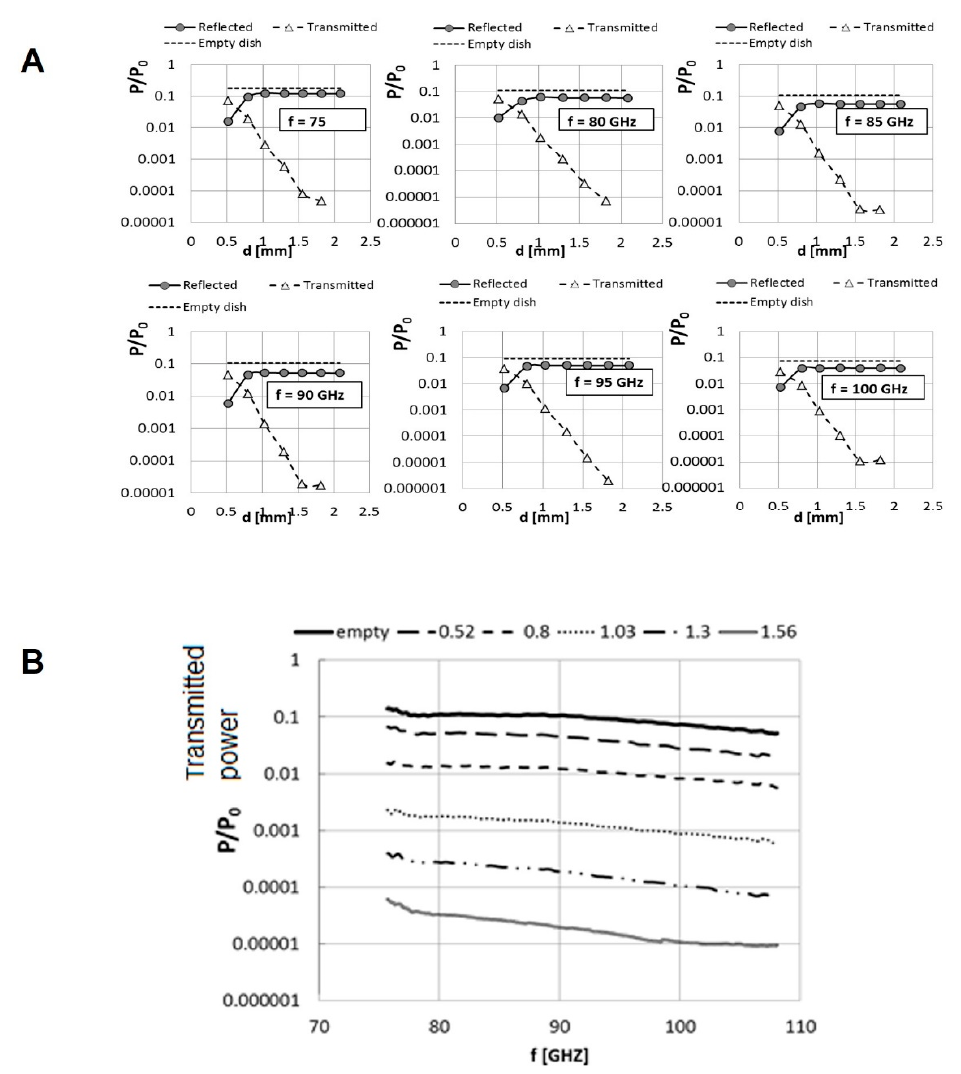
Figure 2. Dependence of the reflected and the transmitted signals on the level of the RPMI 1640 medium layer’s thickness ( A ). Signals were evaluated for di ff erent frequencies ranging from 75 to 100 GHz. For the empty dish, only the transmitted signal and not the reflected signal is presented. Shown is one representative sample of seven dishes that were irradiated for each frequency. Exposure times were a few seconds and the temperature of the medium was measured to be 24–26 ◦ C. Dependence of the transmitted power through the Petri dish on the frequency of irradiation ( B ). The signals were normalized to the antenna emitting power P 0 ≈ 1 mW on an empty